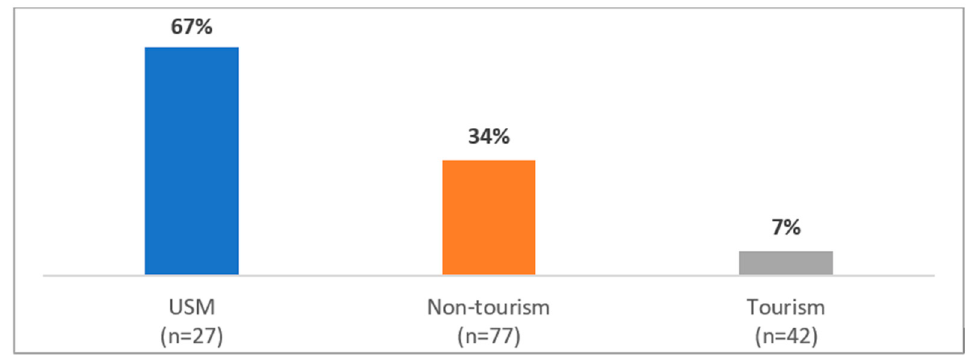
Figure 11. Work from home by most recent industry type ( n = 146).